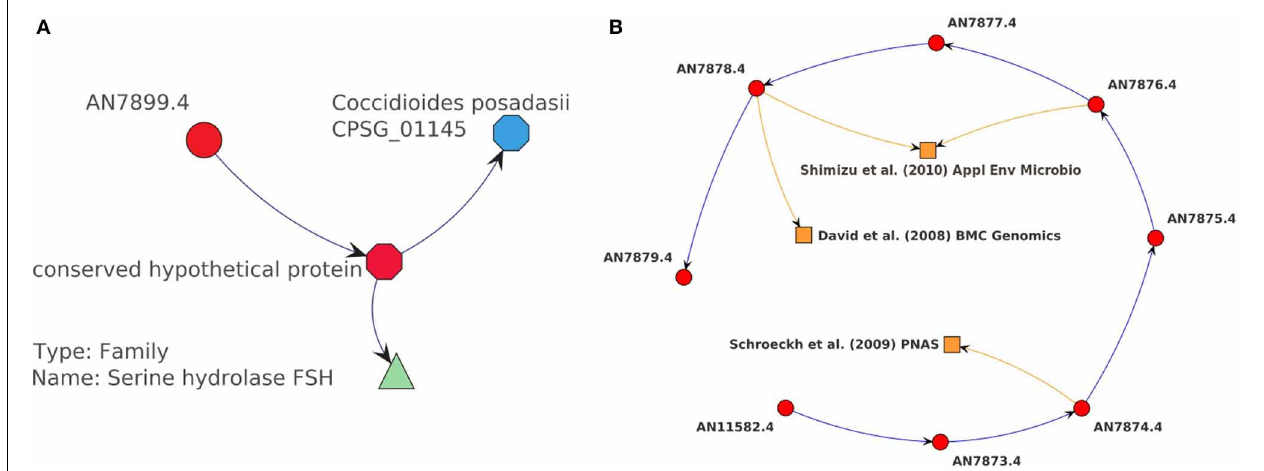
FIGURE 6 | Example annotation resulting from the usage of context-sensitive menus. (A) A gene of interest (AN7899.4) is explored further by retrieving the protein sequence (CADANIAG0000 3918) from BioMart web service. This sequence is used to invoke the InterProScan which predicts a serine hydrolase domain. The protein sequence is also used to execute a bidirectional BLAST-search finding